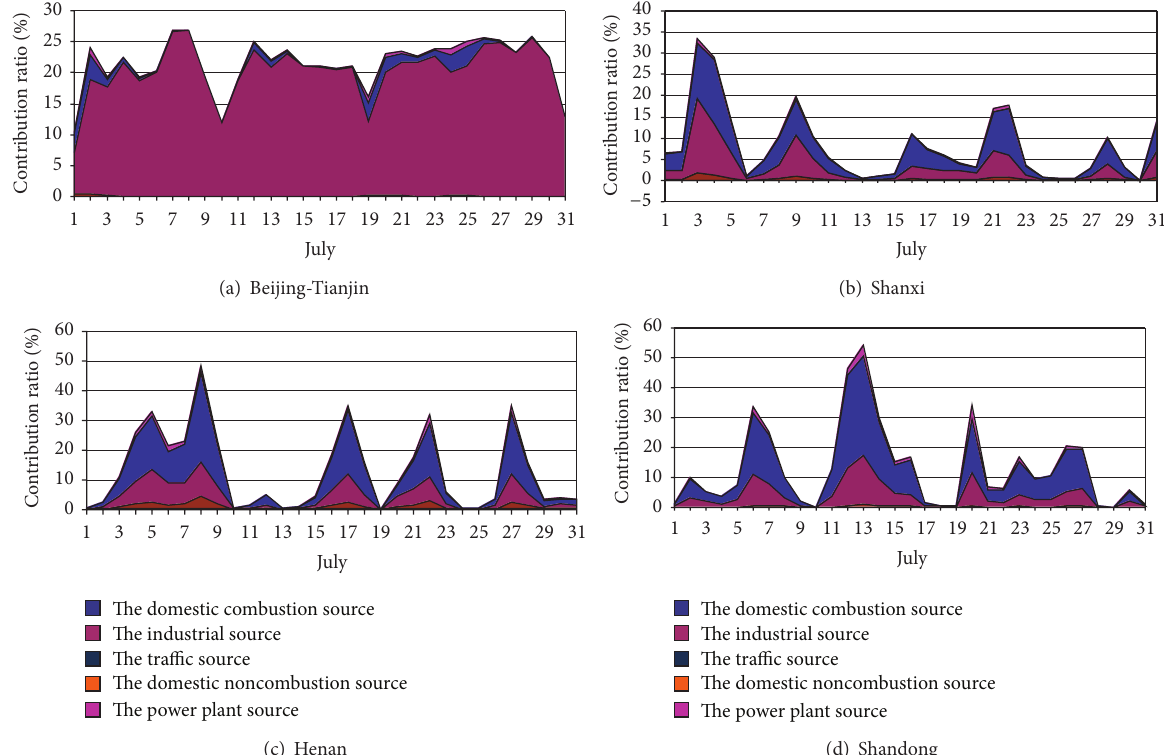
Figure 4: Contribution ratios of daily average PM 2.5 concentration from sector sources of the surrounding areas to Shijiazhuang in July 2007.